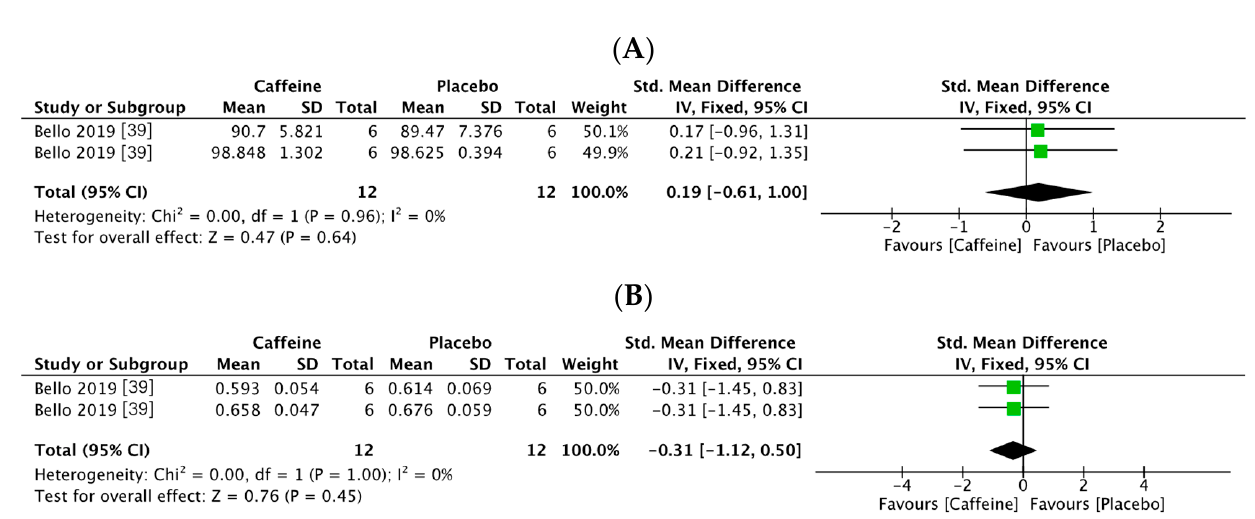
Figure 4. Forest plots of inhibitory control responses observed in athletes in conditions of supplementation with caffeine vs. a placebo. ( A ) Response accuracy; ( B ) response speed.